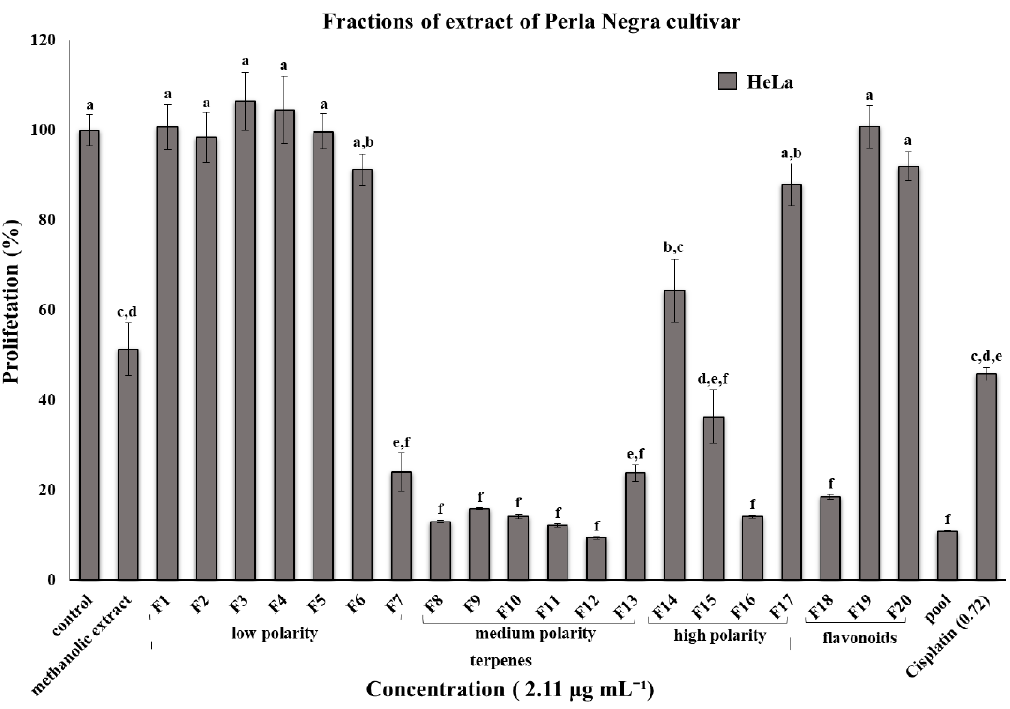
Figure 2. Proliferation assay. The effect of the Perla Negra cultivar fractions on the HeLa cell line. The polarity of fractions is related to the mobile phase of the TLC in the tracking of the terpene compounds. The cells were incubated with all fractions, the methanolic extract, and the pool at the same concentration (2.11 µg·mL − 1 ) and Cisplatin (0.72 µg·mL − 1 ) for 72 h. Different letters indicate